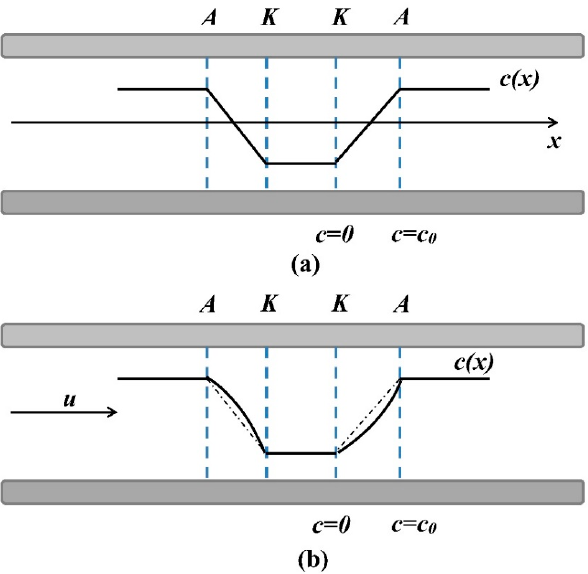
Figure 2. The carrier concentration gradient in the transducing cell under the influence of external pressure variations. c(x) is the ion concentration; ( a ) distribution without external pressure variations; ( b ) the distribution of concentration c(x) varies under the oncoming flow of liquid; u = fluid flow rate. A = anode, K = cathode.